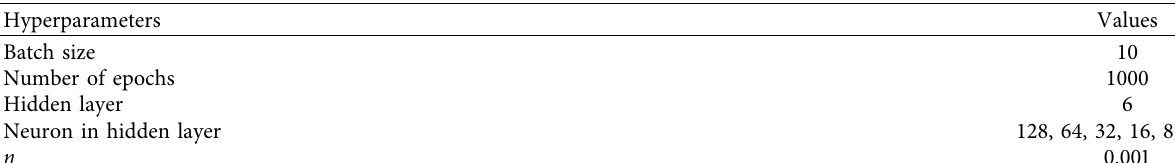
Table 5: Te hyperparameter settings of our model.